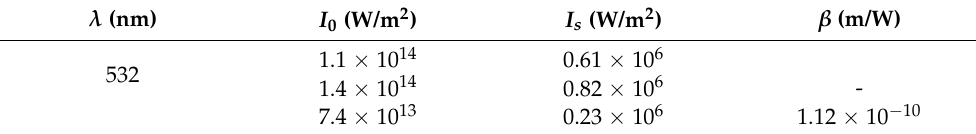
Table 1. The nonlinear optical parameters of Ag@V2C monolayer flake hybrids. λ (nm)